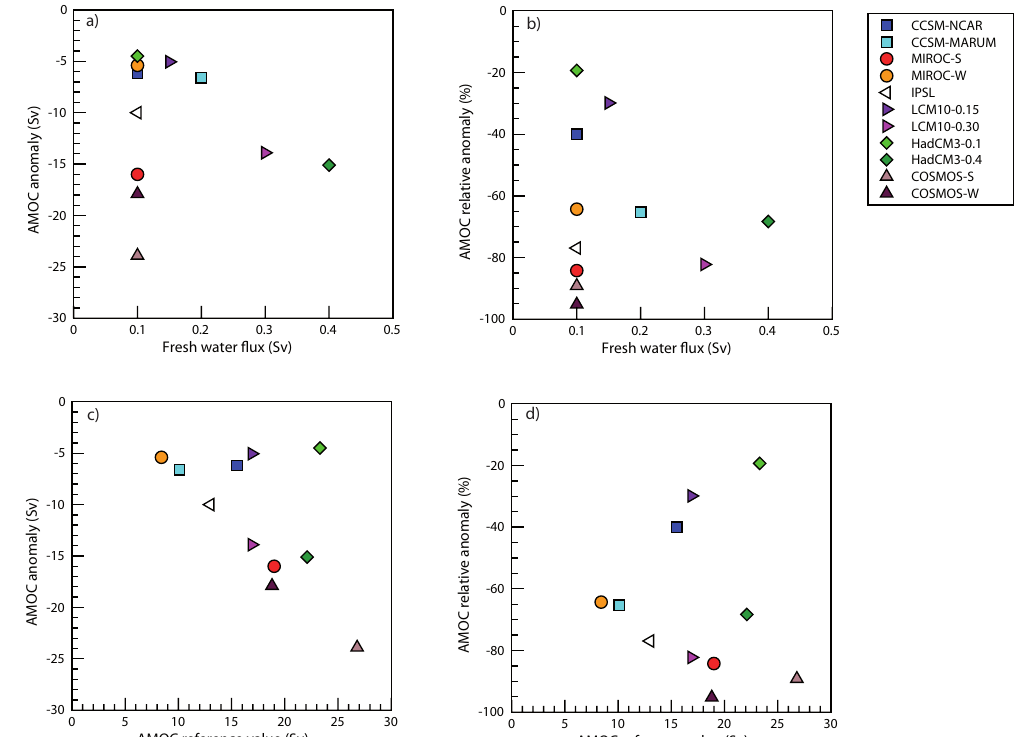
Fig. 1. Summary of AMOC behaviour in the different fresh water hosing simulations. The AMOC is defined as the maximum of the meridional streamfunction of the North Atlantic circulation in the Northern Hemisphere below 500m. The “AMOC anomaly” is defined as AMOC fw –AMOC ref , where AMOC ref is the value of the AMOC in the reference run and AMOC fw in the fresh water hosing run. The “AMOC relative anomaly”, in %, is defined as 100 × (AMOC fw –AMOC ref )/AMOC ref